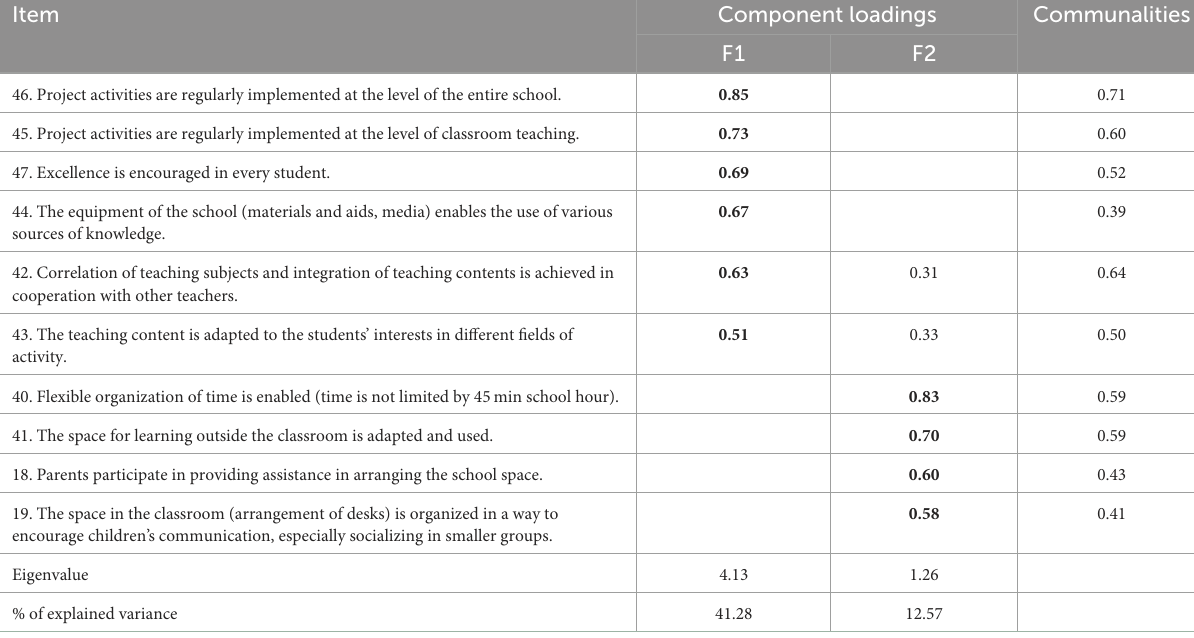
TABLE 1 Results of the principal component analysis of the Scale of the State of School Culture .